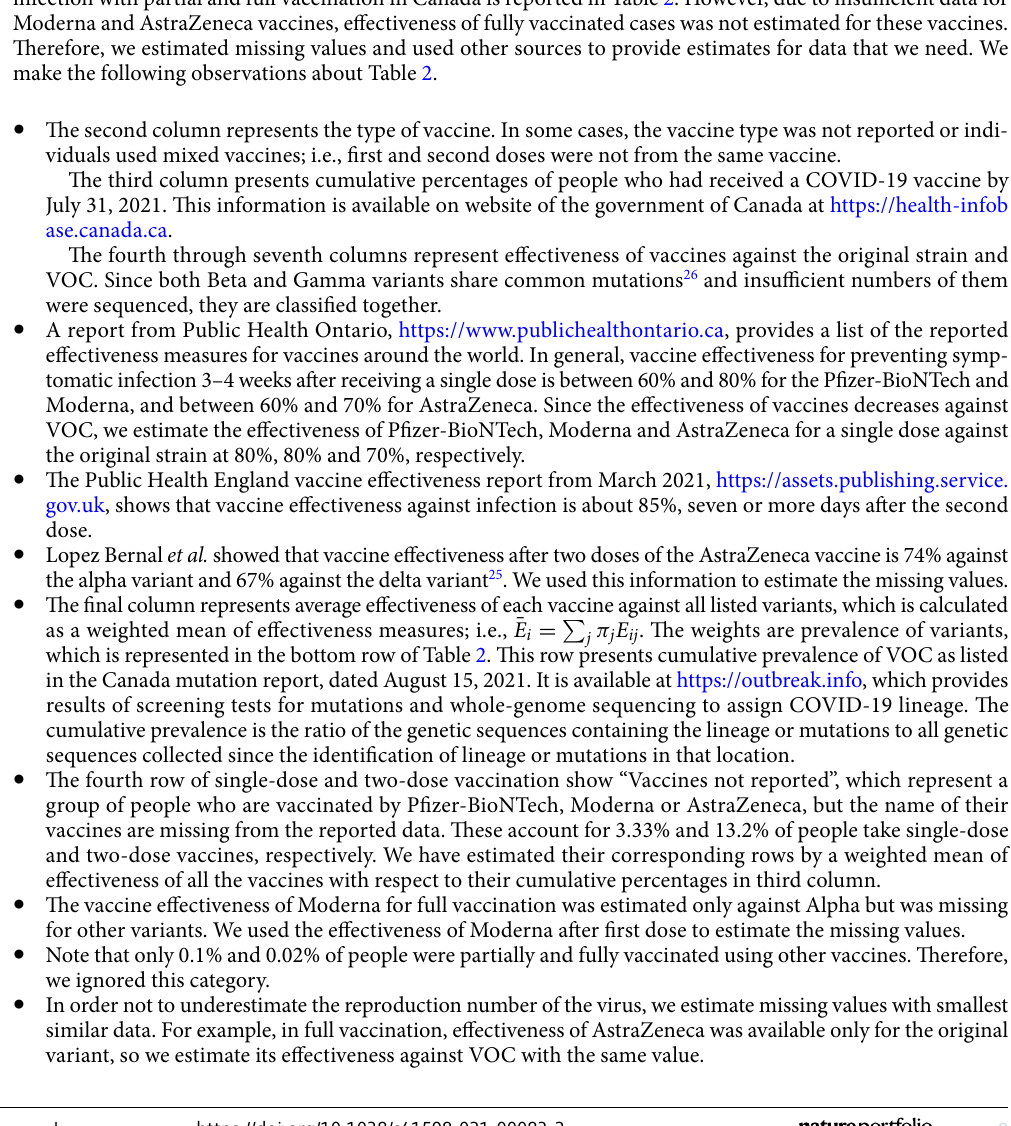
vaccines against VOC has been estimated by Nasreen et al. 26 . Estimates of the effectiveness of vaccines against infection with partial and full vaccination in Canada is reported in Table 2. However, due to insufficient data for Moderna and AstraZeneca vaccines, effectiveness of fully vaccinated cases was not estimated for these vaccines. Therefore, we estimated missing values and used other sources to provide estimates for data that we need. We make the following observations about Table 2.